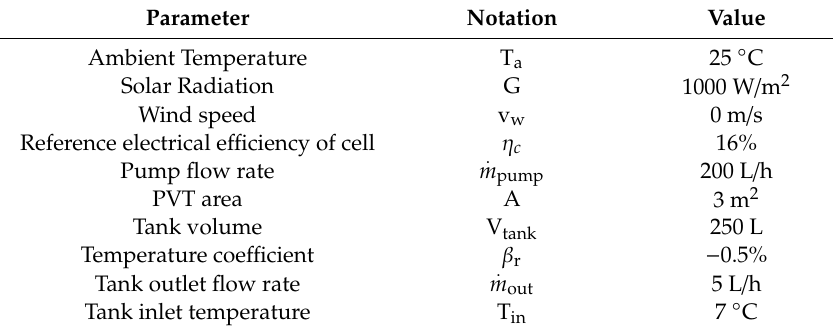
Table 1. Default parameters.